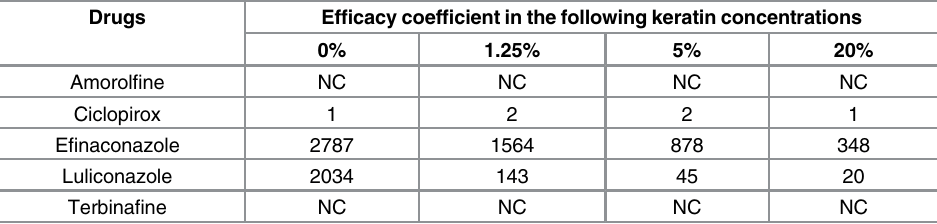
Table 4. Efficacy coefficients of five test drugs determined using MICs in medium with/without keratin.